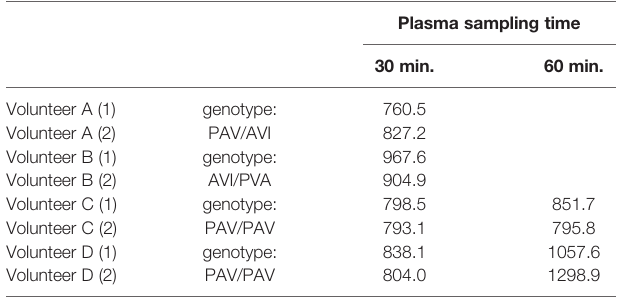
TABLE 1 | Quanti fi cation of AITC plasma levels [nmol/L] after single oral intake of a conventional mustard preparation, as determined using LC-ESI-MS/MS. Plasma sampling